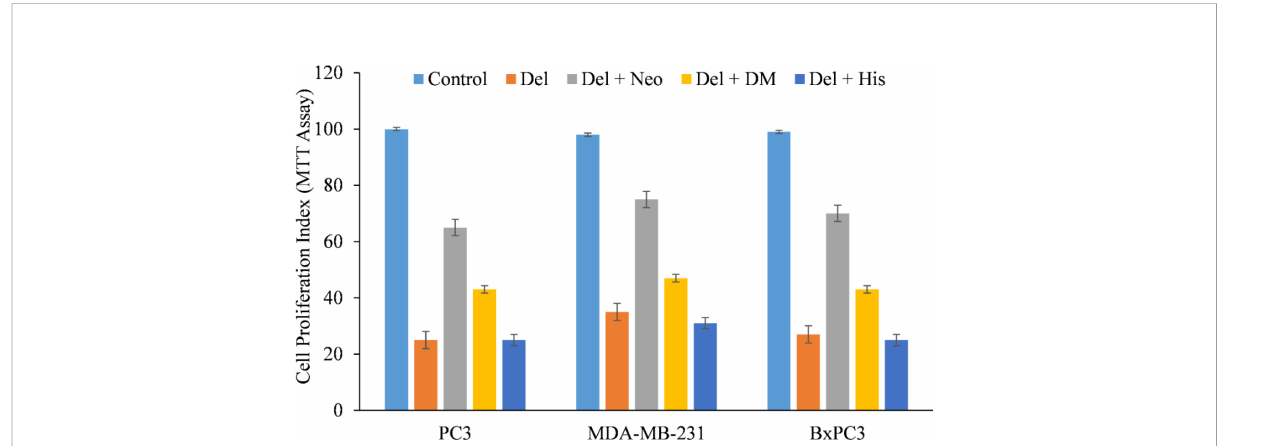
FIGURE 4 The effect of several metal-speci fi c chelators on the antiproliferative activity of delphinidin in three cancer cell lines is depicted. As depicted in the picture, PC3, MDA-MB-231, and BxPC3 cancer cells were treated with 50 µM of delphinidin alone or in the addition of copper chelator neocuproine (Neo), iron chelator desferrioxamine mesylate (DM), or zinc chelator histidine (His). 50 µM was the concentration of metal chelators utilized. After 72 hours of treatment, the MTT assay was performed as indicated in “ Methods. ” The values reported are the S.E. of three separate trials. p ≤ 0.01 when compared to respective untreated control was treated as signi fi